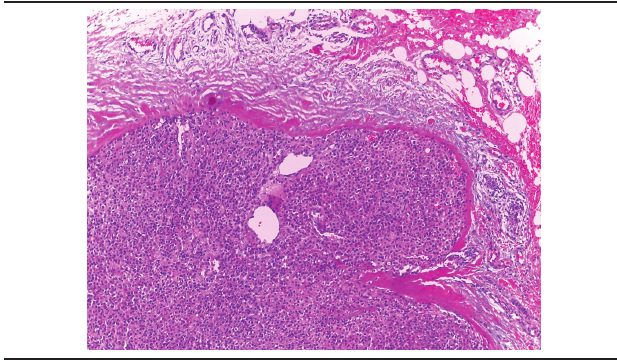
Figura 1 − Histopatologia, 100× HE: lesão encapsulada com células redondas e pequenas HE: hematoxilina e